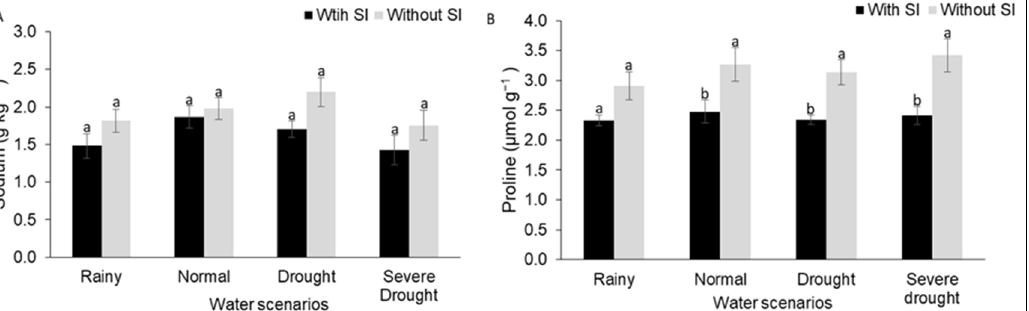
Figure 9. Sodium ( A ) and proline ( B ) concentrations in mature leaves of maize in response to presence or absence of supplemental irrigation (SI) with brackish water of ECw = 4.5 dS m − 1 . Means followed by the same letters do not differ ( p ≥ 0.05) from each other according to the Tukey test. Sodium and proline concentrations represent the average of three sampling dates (47, 56, and 60 days after planting). Error bars represent the standard error of the mean ( n =